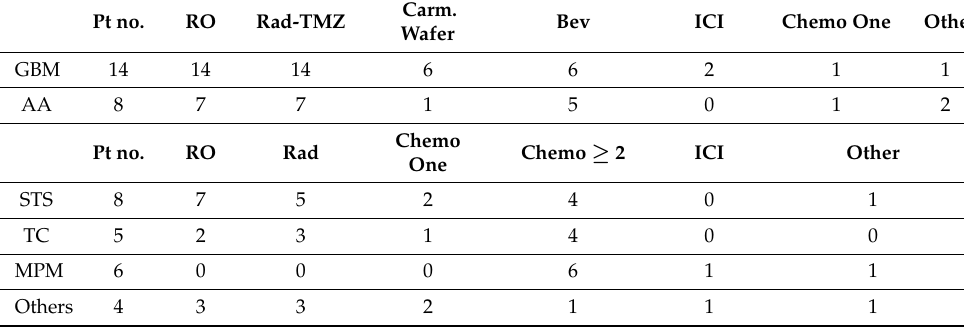
Table 3. Previous treatment